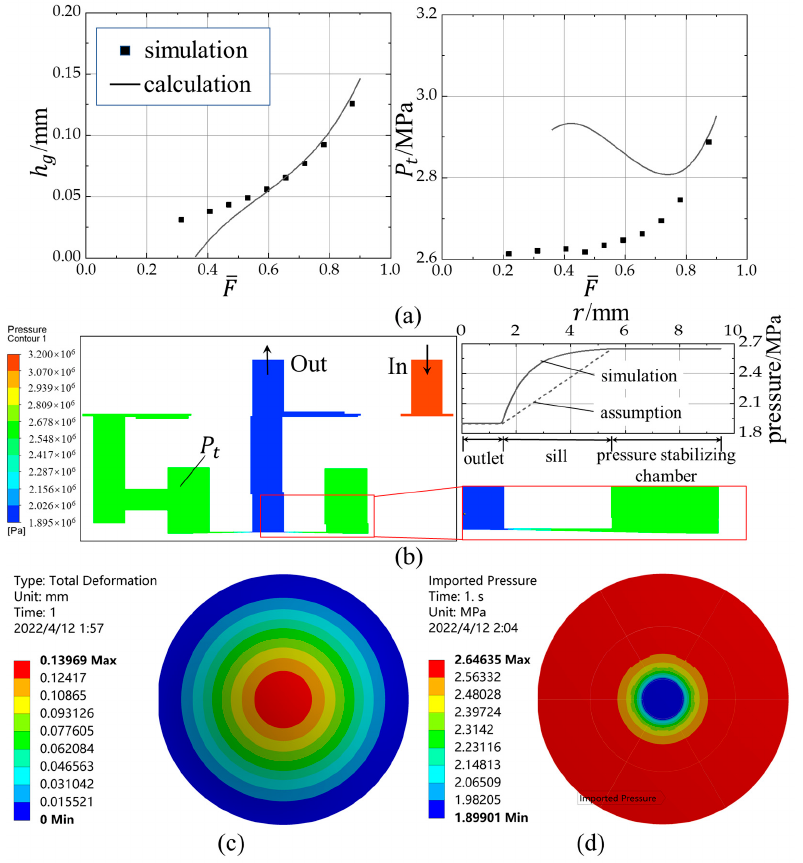
Figure 13. Simulation results and calculations of a PSMR for NO. 1. ( a ) Simulation results and cal- culations of PSMR; ( b ) Pressure field of PSMR when 𝑃 (cid:3045) = 1.9 MPa; ( c ) Deflection of the membrane calculations of PSMR; ( b ) Pressure field of PSMR when P r = 1.9 MPa; ( c ) Deflection of the membrane toward the cylindrical sill when 𝑃 (cid:3045) = 1.9 MPa; ( d ) Pressure distribution on the membrane toward toward the cylindrical sill when P r = 1.9 MPa; ( d ) Pressure distribution on the membrane toward the the cylindrical sill when 𝑃 (cid:3045) = 1.9 MPa. cylindrical sill when P r = 1.9